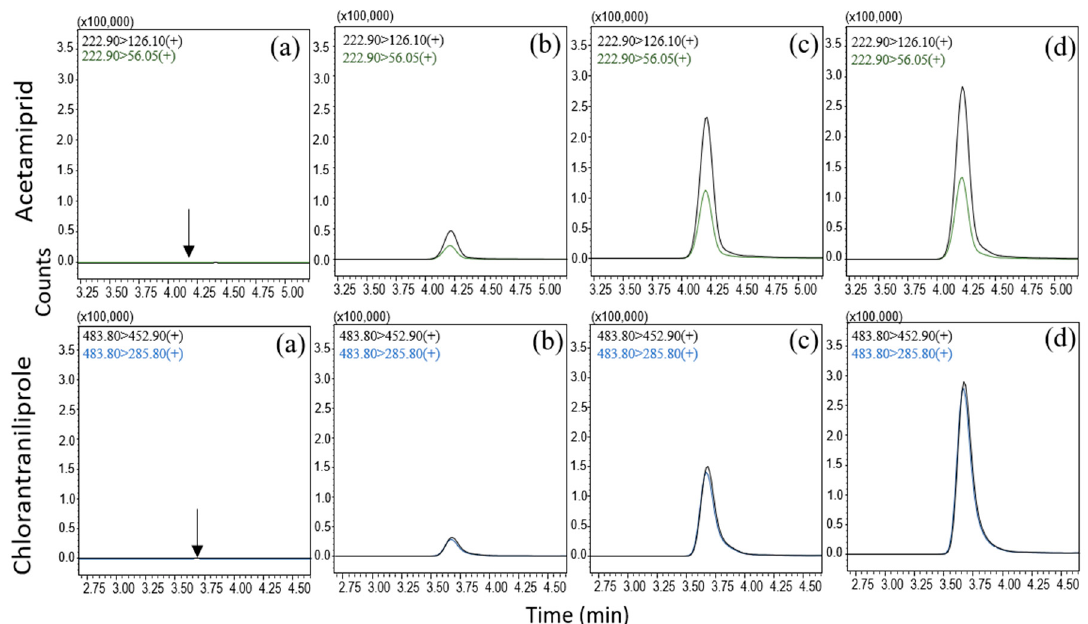
Figure 2. The representative chromatograms of acetamiprid (top) and chlorantraniliprole (bottom): Blank kimchi cabbage ( a ), spiked at 0.05 mg / kg ( b ), spiked at 0.25 mg / kg ( c ), and the field samples two days after spraying ( d ).